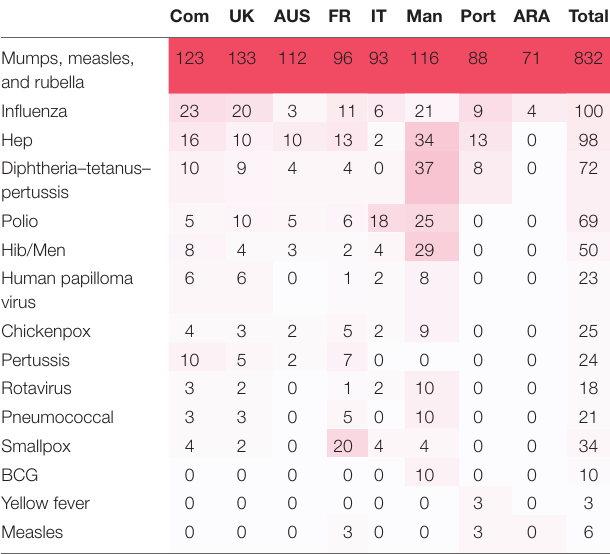
Table 2 | Vaccines discussed by webpages in the different search engine result page